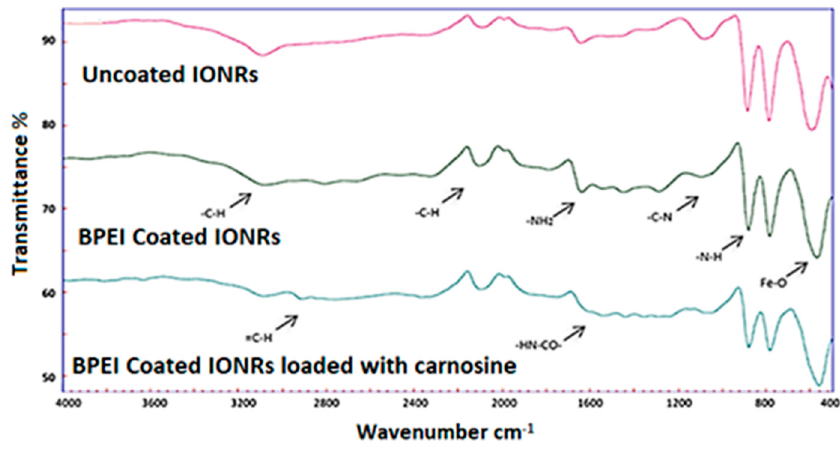
Figure 2. Thermal gravimetric analysis (TGA) analysis between 50 and 700 °C of uncoated IONRs (green), IONR capped with BPEI (blue) and capped IONR loaded with carnosine (red). The FT ‐ IR attenuated total reflectance (ATR) spectrum of the carnosine loaded carrier displays characteristic bending bands between 1474 and 1630 cm − 1 that are attributed to the peptide bond of carnosine, and a band at 2900 cm − 1 from the imidazole ring of L ‐ histi ‐ dine. In addition, the strong stretch at 3000 cm − 1 is due to the absorbance due to alkane C ‐ H (Figure 3) [37], and the peptide bond overlaps the strong bending band at 1474 and 1630 cm − 1 of the NH 2 group. Despite the annealing of the BPEI as a template during the synthe ‐ sis of the IONRs, it is clear that there remains trace residual polymer on the nanorods.